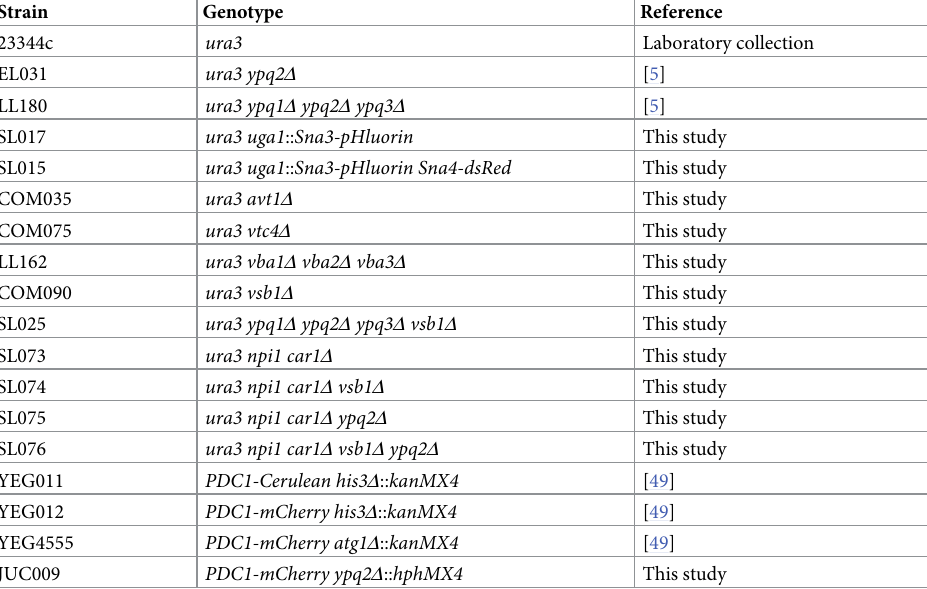
Table 2. Strains used in this